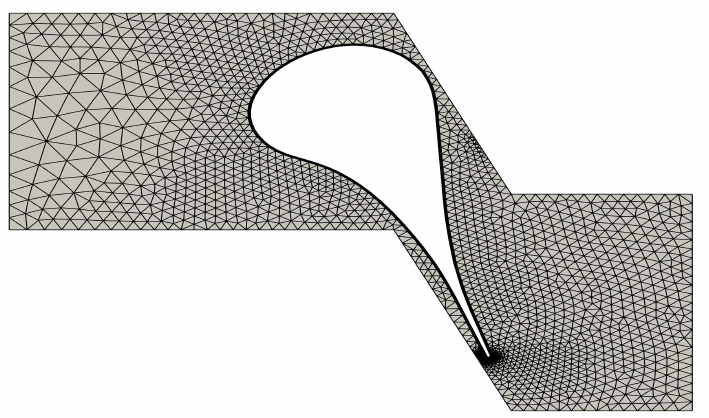
Figure 3. ORC nozzle. Mesh of the blade channel, 5305 hybrid elements (hexahedral in the boundary layer and prisms outside). The geometry is distorted because the blade design is confidential property of the manufacturer.